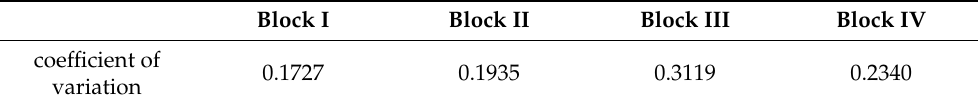
Figure 8. The model of brightness characteristic. ( a ) The model of row direction. ( b ) The model of column direction.